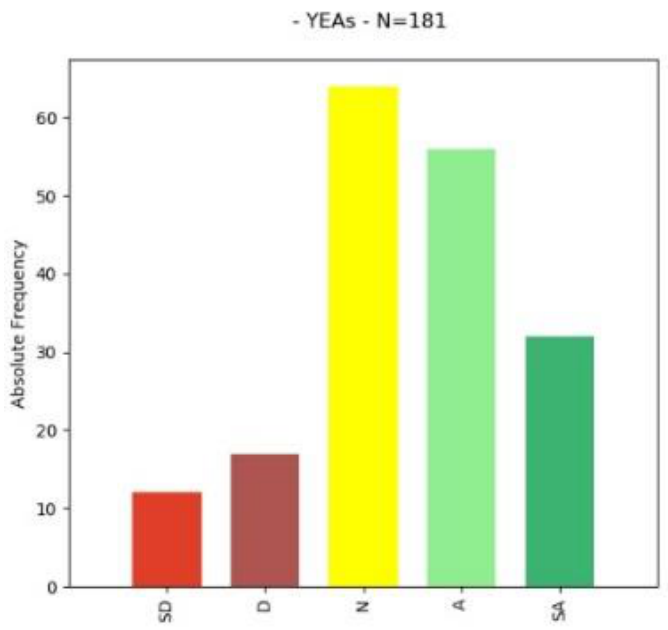
Fig. 6. STEP and YAEs trust in local